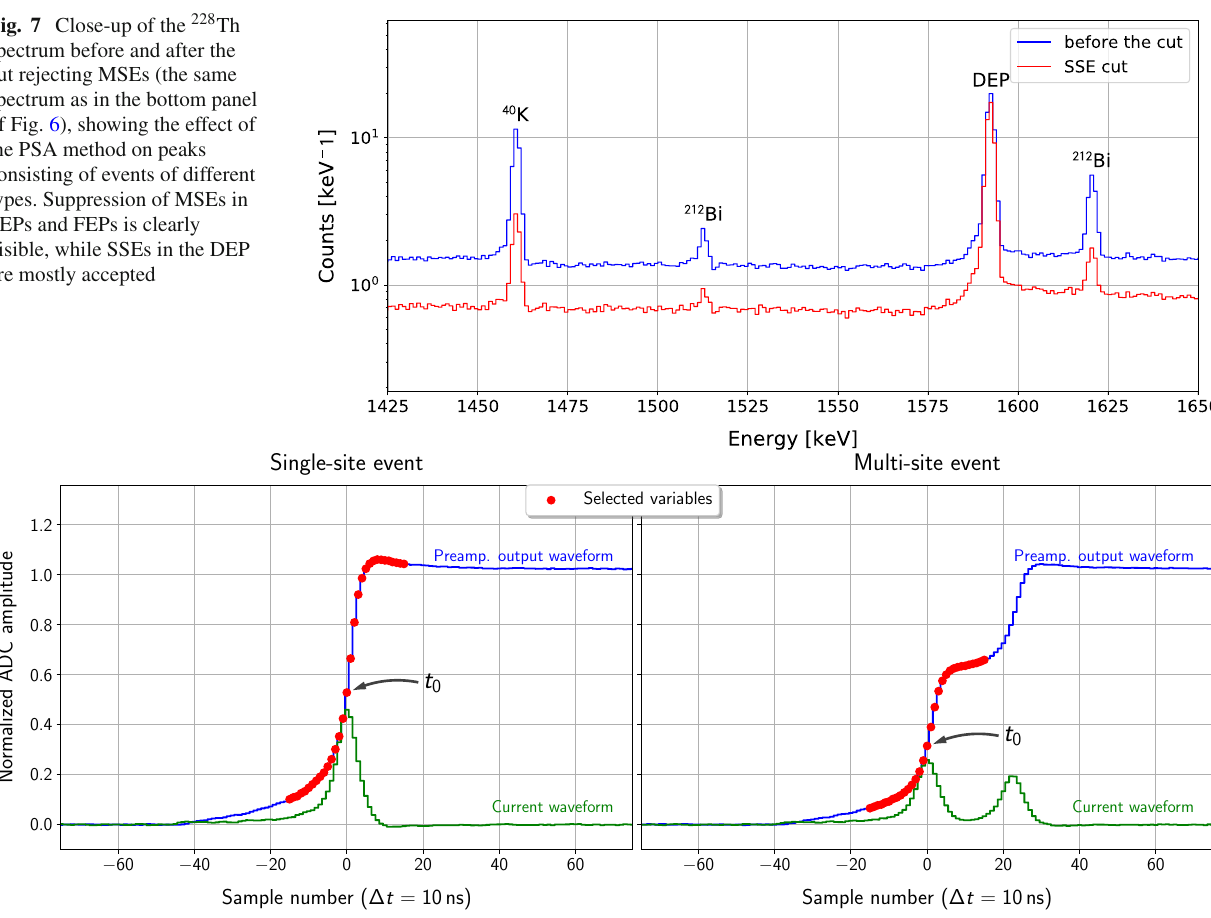
Fig. 8 Example of digitized pulses from the preamplifier (normalized with respect to the amplitude) for typical single- and multi-site events. The plot shows also corresponding current pulses (obtained by the differentiation, in green) and points (in red) selected for pulse shape analysis